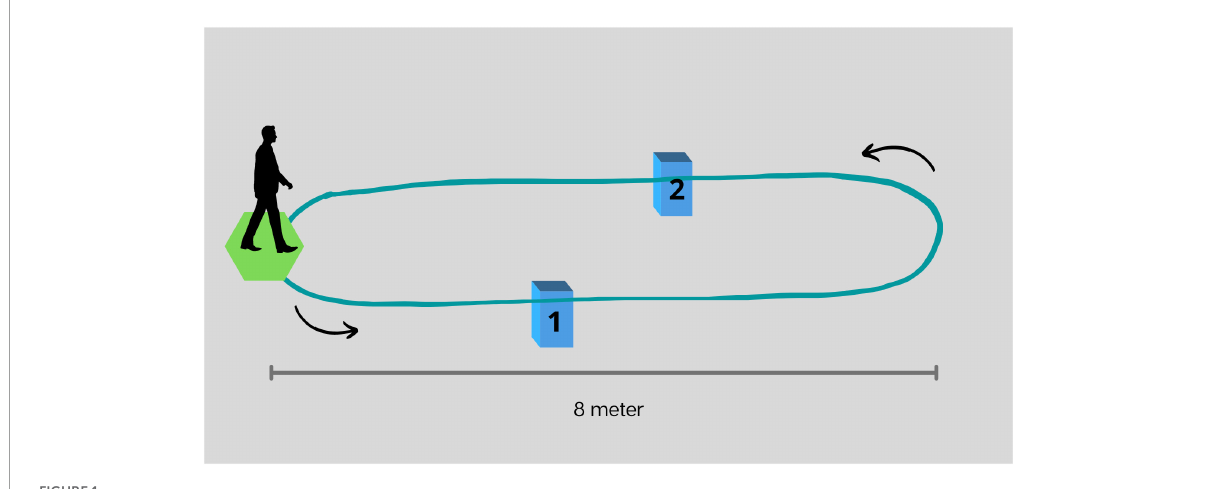
FIGURE1 Representation of the walkway and placement of obstacles for walk while negotiating obstacles. The first obstacle (1), 15 cm in height, and placed at a 4-m distance from the start of the walking course, and the second (2), 10 cm in height, and placed at a 6-m distance.